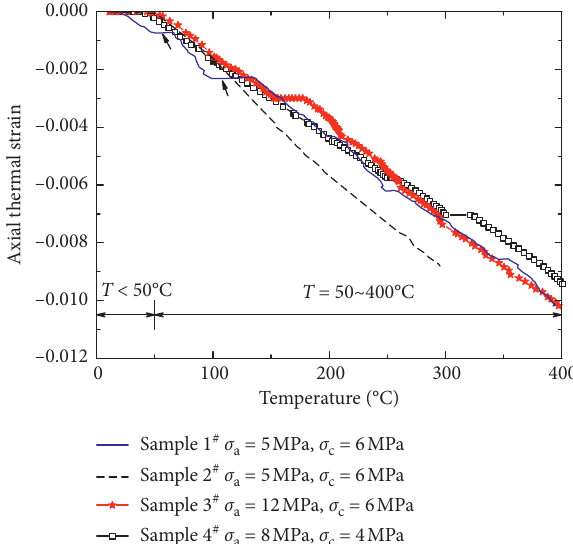
Figure 4: Axial thermal expansion of mudstone at 400 ° C vs.